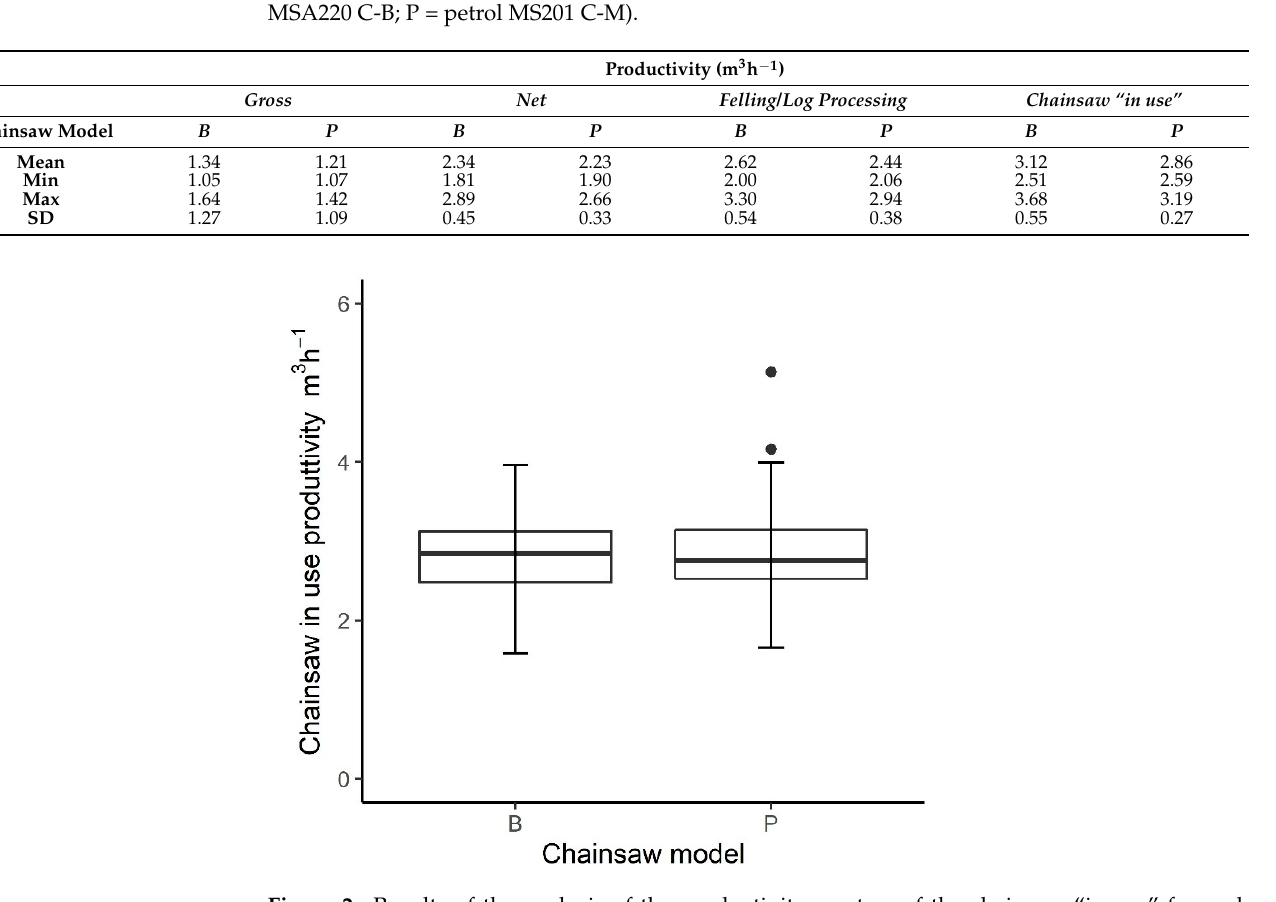
Figure 2. Results of the analysis of the productivity per tree of the chainsaw “in use” for each chainsaw model (B = battery MSA220 C-B; P = petrol MS201 C-M) in the sub-sample of 54 trees. The median and spreading-range values are represented. Black dots are outliers.